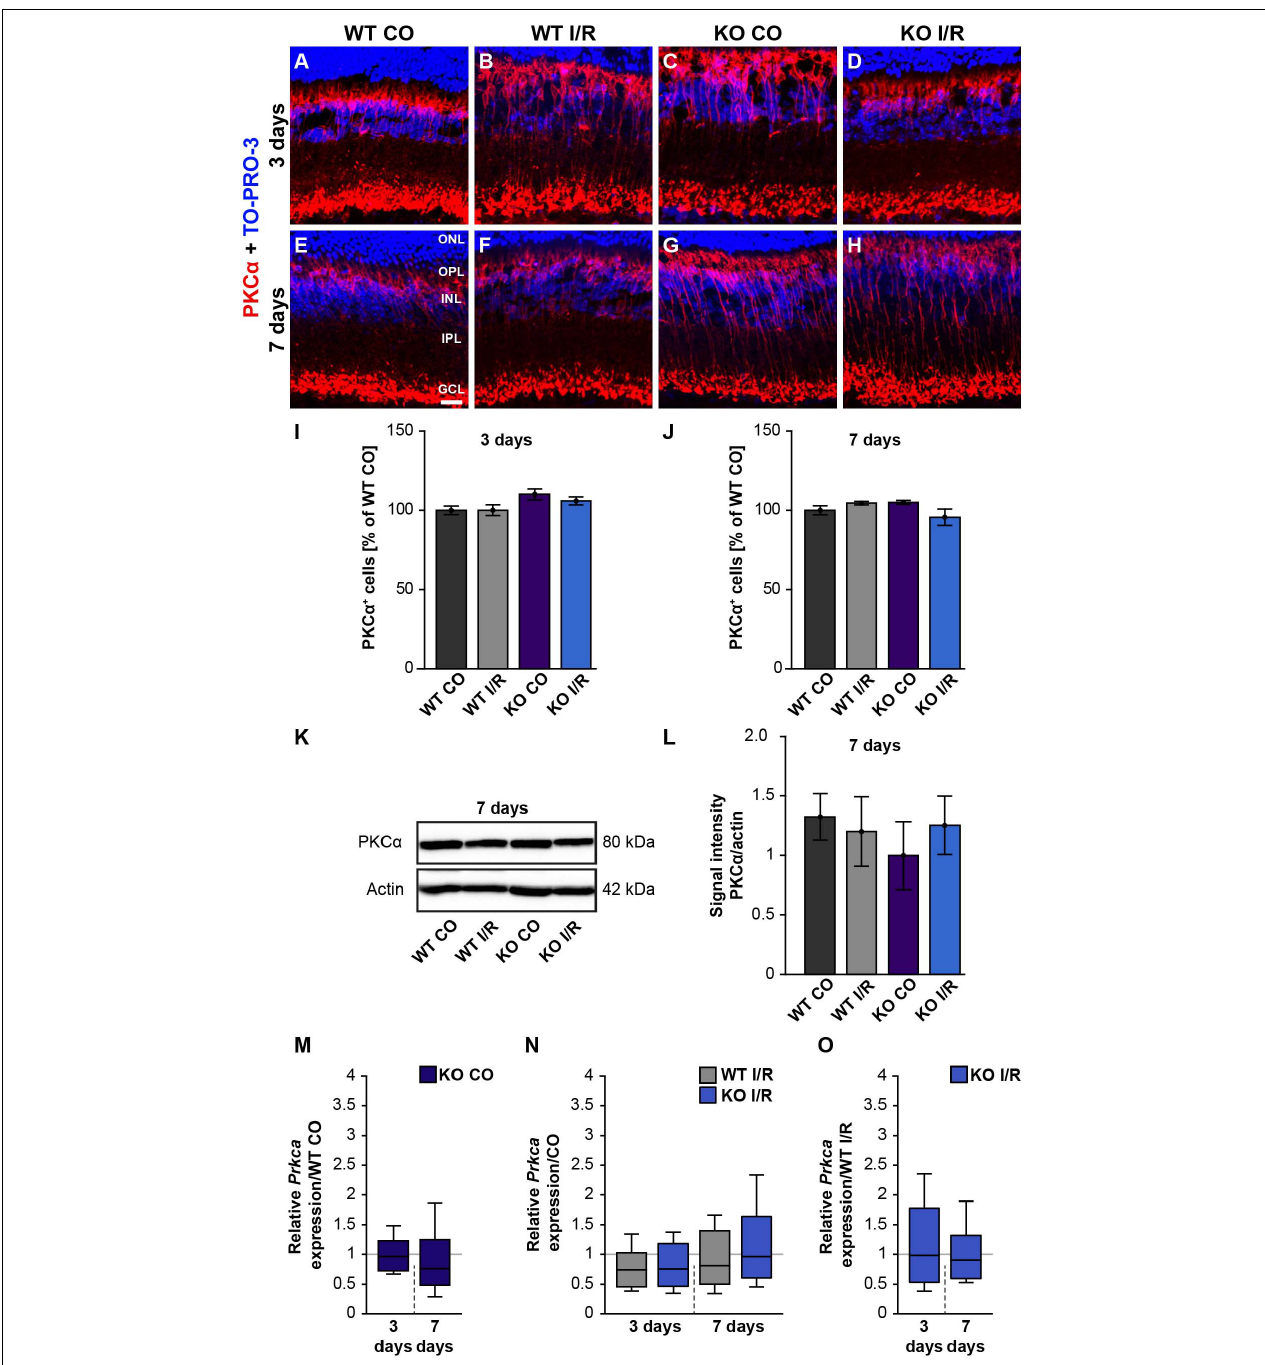
FIGURE 4 | Rod-bipolar cells are not affected early ischemia. (A–H) Anti-PKC α was used to label rod-bipolar cells (red) 3 and 7 days post-I/R. TO-PRO-3 (blue) was used as nuclear counterstain. (I,J) Countings of PKC α + cells demonstrated no changes between control and ischemic WT and KO retinae 3 and 7 days post-I/R. The WT CO group was set to 100%. (K,L) In line with the immunohistochemical results, comparable protein levels of PKC α were detected via Western blot in all four groups 7 days post-I/R. (M–O) RT-qPCR analyses showed an unaltered Prkca mRNA expression level in all groups at both points in time after ischemia. Groups were evaluated using two-way ANOVA followed by Tukey’s post hoc test. Data are indicated as mean ± SEM in panels (I,J,L) . For RT-qPCR results, groups were analyzed using the pairwise fixed reallocation and randomization test. Data are shown as median ± quartile ± minimum/maximum in panels (M–O) . p > 0.05. n = 4–5/group. Scale bar = 20 µ m. ONL: outer nuclear layer; OPL: outer plexiform layer; INL: inner nuclear layer; IPL: inner plexiform layer, GCL: ganglion cell